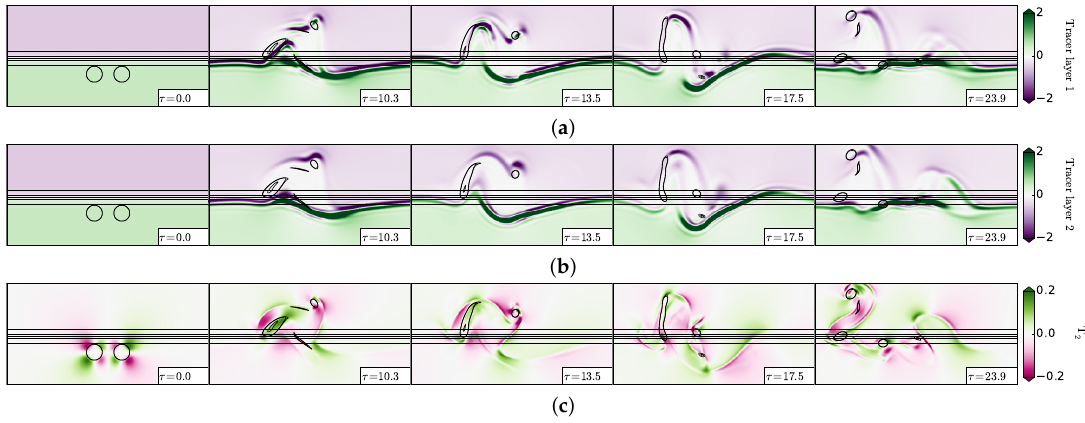
Figure 20. Tracer and strain evolution during the interaction of two cyclones for d / R = 3.4, γ R = 3, d c / R = 2. ( a ) Tracer in the upper layer; ( b ) tracer in the lower layer; ( c ) strain field T 2 in the lower layer (Equation (6)). The black contours indicate the topographic slope (Equation (12); straight lines) and the upper layer vorticity contours showing the two cyclone